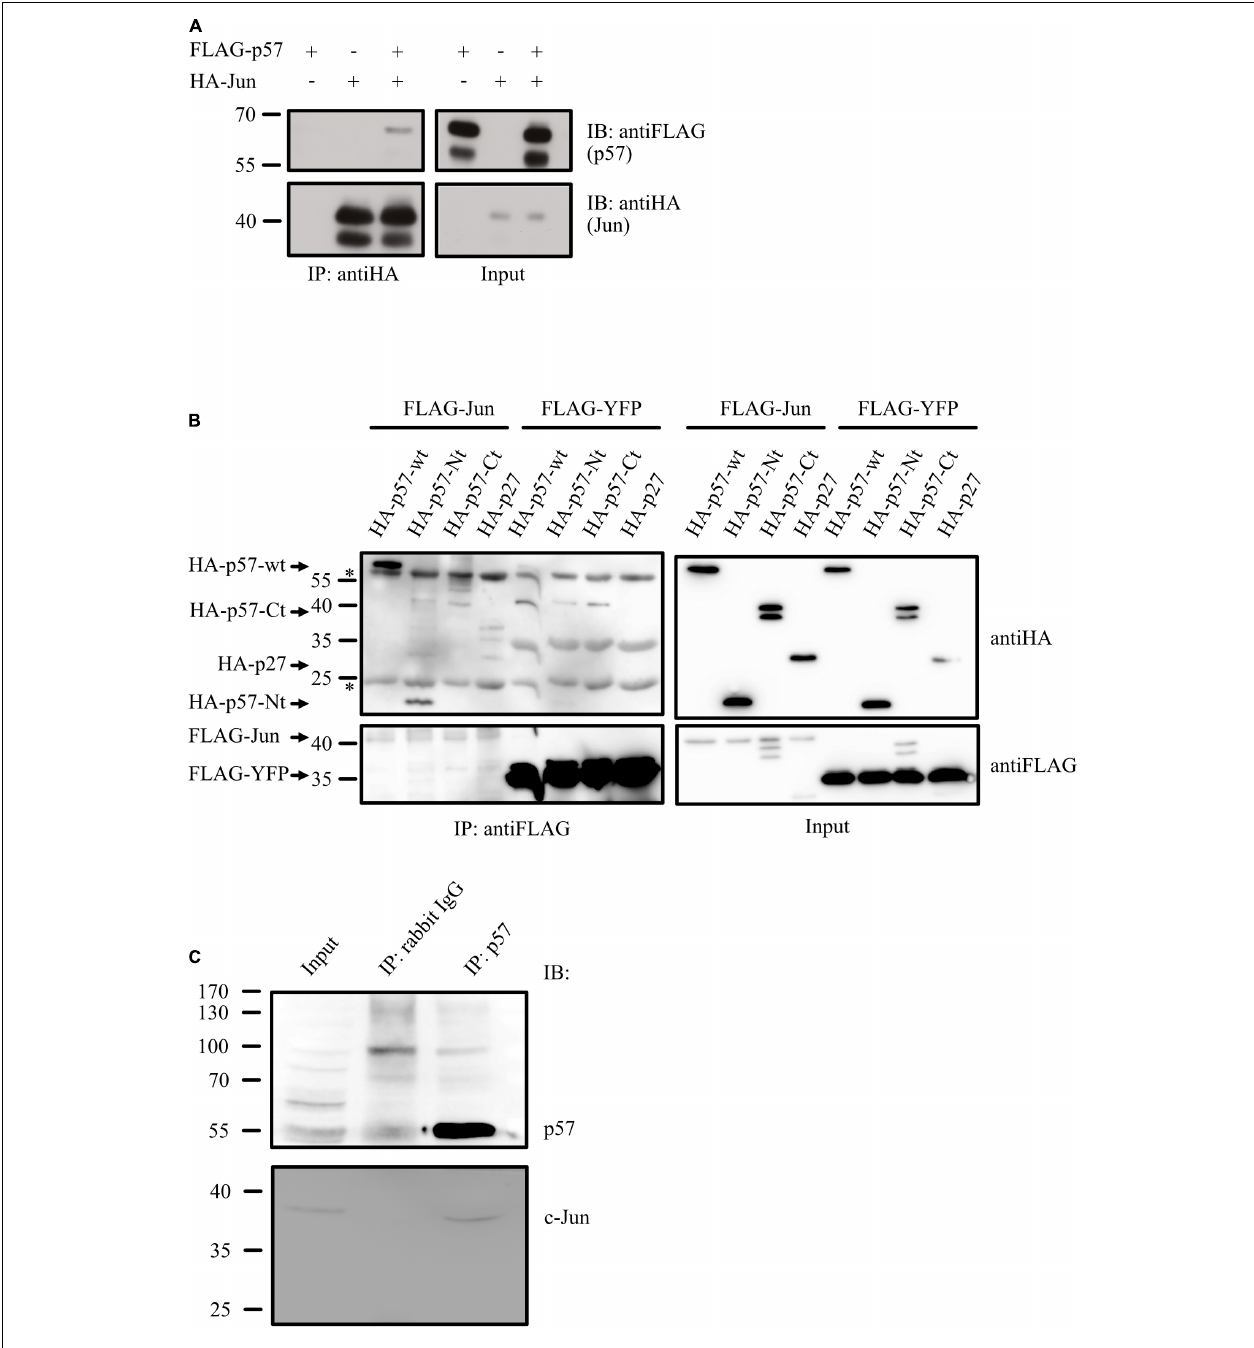
FIGURE 4 | p57 is in a complex with c-Jun. (A) Co-immunoprecipitation experiment (Co-IP) followed by immunoblotting showing binding of FLAG-tagged p57 to HA-tagged c-Jun. 293 cells were transfected with expression plasmids for HA-Jun and FLAG-p57. HA-tagged c-Jun was precipitated by using anti-HA mouse monoclonal antibodies. Immunoprecipitates (IP: antiHA) and 1% of the total protein extract used for the IP (Input) were subjected to immunoblot analysis. Upper panels show FLAG-p57, lower panels HA-Jun. Molecular weight markers are indicated left. (B) Complex formation of c-Jun with the aminoterminal domain of p57. 293 cells were transfected with expression constructs for FLAG-Jun, HA-p57 and amino- and carboxyterminal domains of p57 (HA-p57-Ct, HA-p57-Nt). FLAG-tagged YFP (FLAG-YFP) was expressed and used as a control. FLAG-tagged c-Jun was precipitated by using anti-FLAG mouse monoclonal antibodies. Immunoprecipitates (IP: antiFLAG) and 1% of the total protein extract used for the IP (Input) were subjected to western-blot analysis. Upper panels show HA-p57 and mutants, lower panels FLAG-Jun/FLAG-YFP. Molecular weight markers are indicated left. Heavy and light chain of the antibodies used in the IPs are indicated ( ∗ ). (C) Endogenous p57 is in a complex with endogenous c-Jun. p57 was immunoprecipitated from extracts of HRT-18 cells using p57-specific rabbit polyclonal antibodies. An IP with rabbit IgG was performed as a control. Immunoprecipitates (IP: p57, IP: rabbit IgG) and 5% of HRT-18 extract used for the IP (Input) were subjected to immunoblot analysis. Upper panel shows p57 and lower panel c-Jun, both detected with mouse monoclonal antibodies. Molecular weight marker is indicated left.